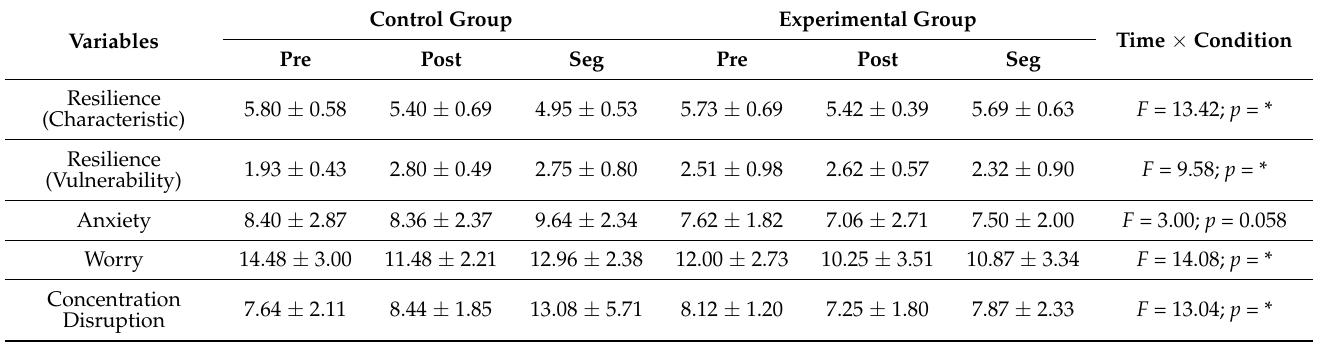
Table 3. Changes in psychological variables during 12 weeks. A group